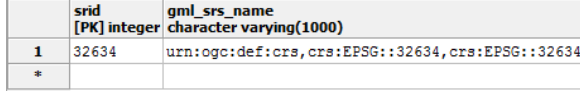
Figure 7. “database_srs” Table of